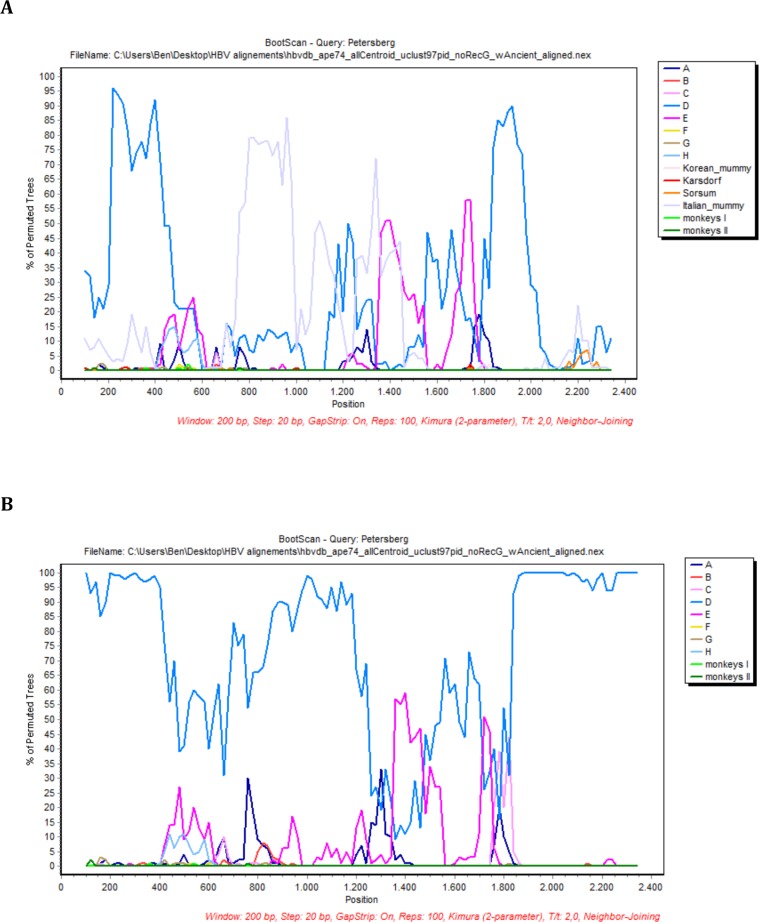
BootScan analysis of the sequence Petersberg.In each case, sequence fragments of 200 bases incrementing by 20 bases, 100 bootstrap replicates, were compared with sequence groups or 50% consensus sequences of (a) the eight human genotypes, two primate genotypes, and four ancient genomes and (b) the eight human genotypes, two primate genotypes (color coded as described in the legend).